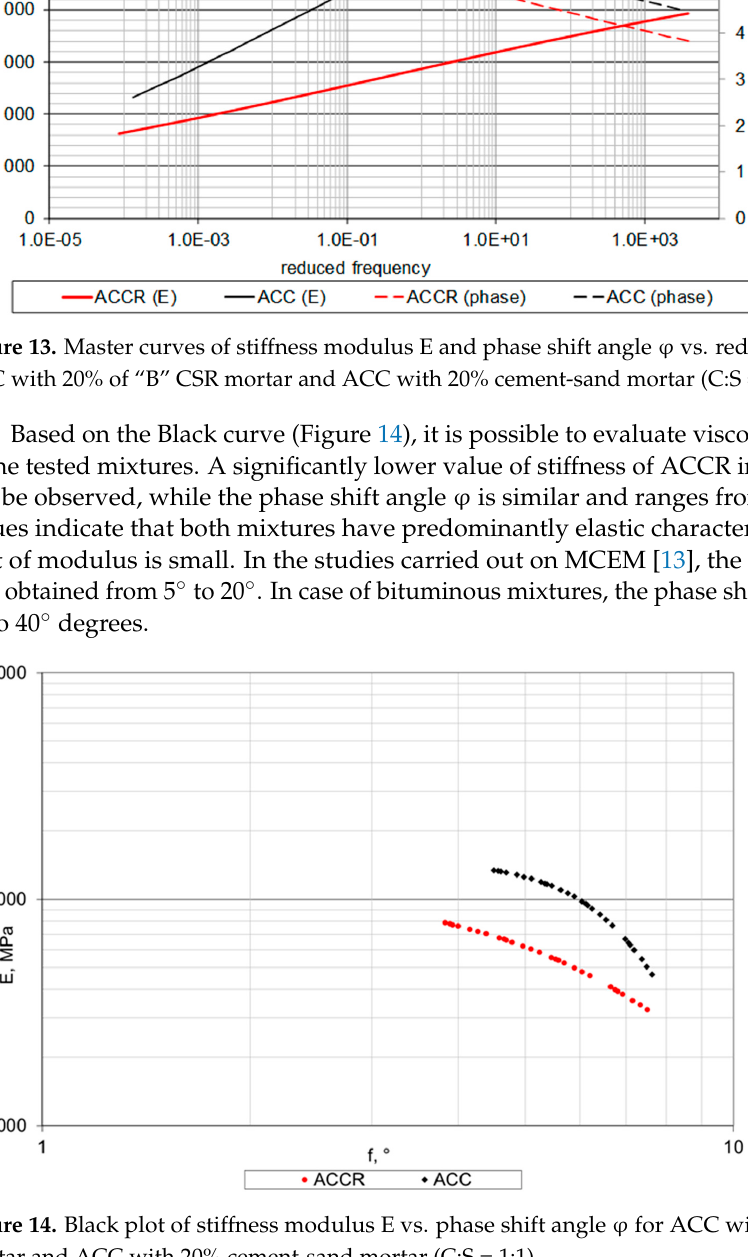
Figure 12. Stiffness modulus E and phase angle vs. frequency for ACC with 20% of “B” CSR mor- tar and ACC with 20% cement-sand mortar (C:S = 1:1) ( a ) stiffness modulus; ( b ) phase angle φ .